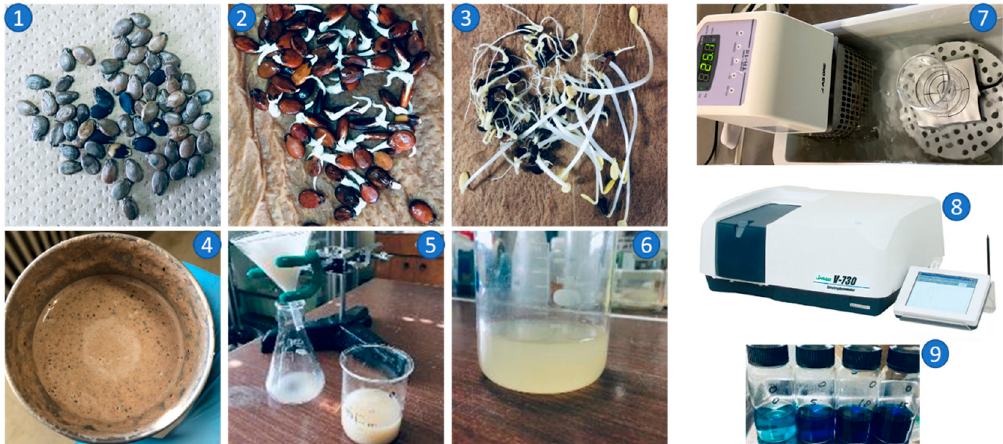
Figure 1. Extraction procedures of crude urease solution from watermelon seeds. ( 1 ) Dry seeds, ( 2 ) germinated seeds at 48 h, ( 3 ) germinated seeds at 96 h, ( 4 ) crushed and blended watermelon seeds, ( 5 ) filtration of the crude extract, ( 6 ) after subsequent filtration translucent crude extract obtained, ( 7 ) constant temperature water bath for urease activity investigation, ( 8 ) UV-vis spectrophotometer, ( 9 ) intensity of dye-solution measured at OD 630 .